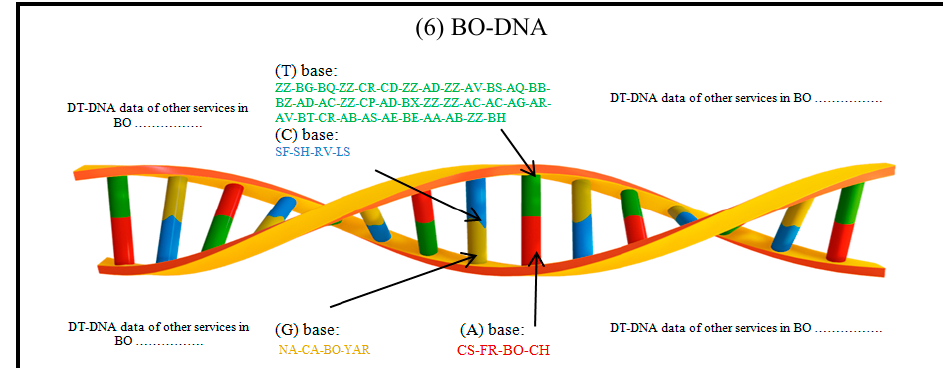
Figure 3. A, T, C and G bases, values of the proposed DT-DNA for QC and BO and results visualized in DNA sequences.